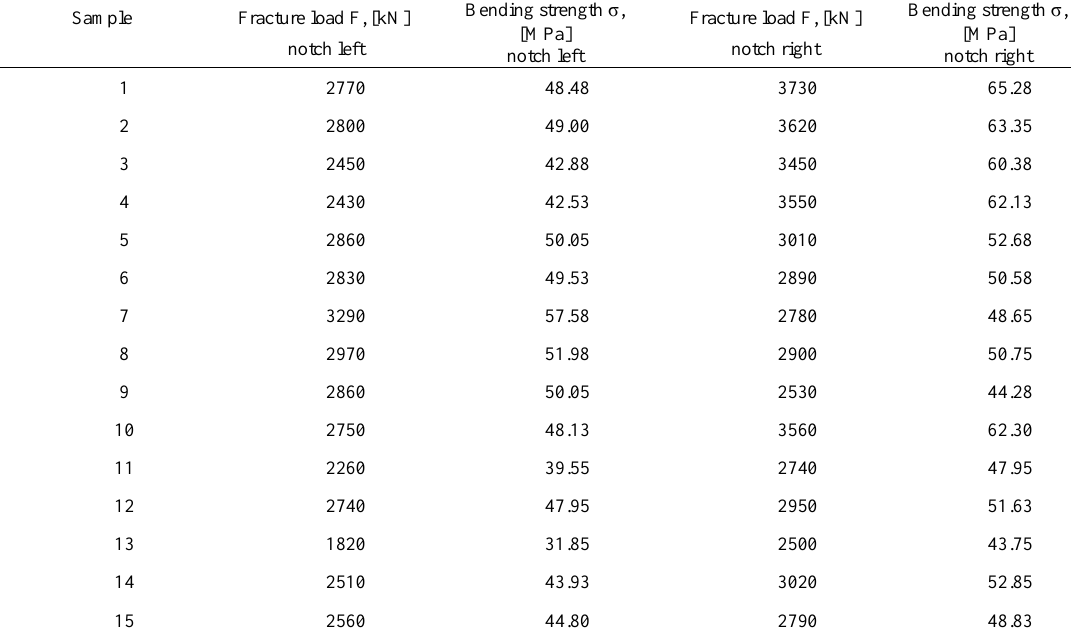
Table 2 The results of bending tests in the vertical position of flat